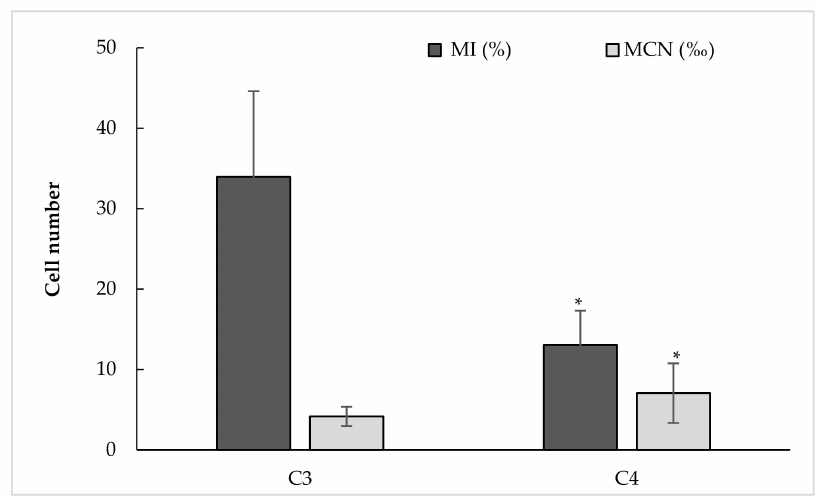
Figure 1. Genotoxicity represented by mitotic index and cells with micronucleus per 100 and 1000 counted cells, respectively, in Vicia root meristematic zone after 48 h of exposure to C3 (EC: 2.01–2.24 dS m − 1 ) and C4 (EC: 3.46–7.00 dS m − 1 ) irrigation water. MI = mitotic index, MCN = micronucleus. Values are mean ± SD (n = 26 for C3 and 24 for C4). * indicates signifi- cant difference between C3 and C4 at p < 0.05.